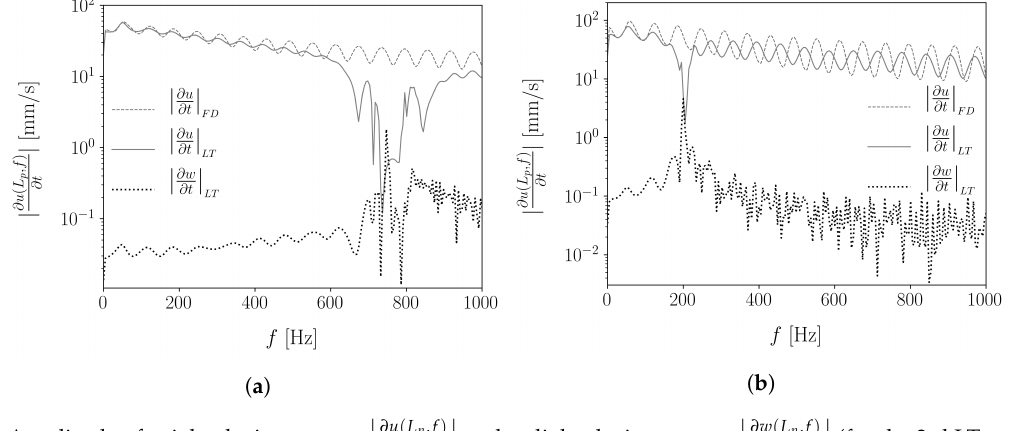
Figure 9. Amplitude of axial velocity spectra, pile with l 2 = 25.2 m, ( a ) R p = 1.1 m and ( b ) R p = 4.1